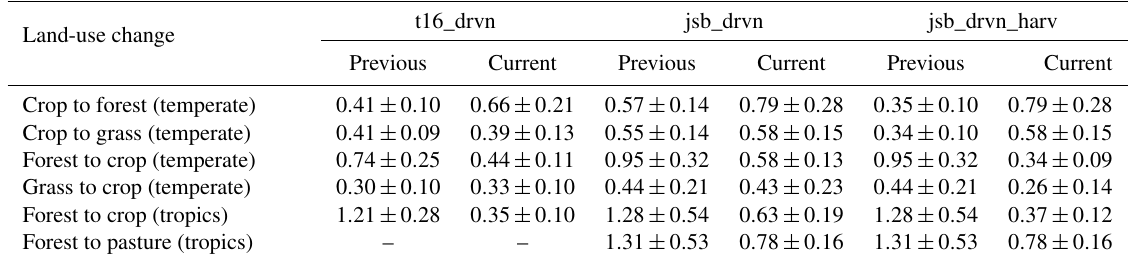
Grass to crop (temperate)